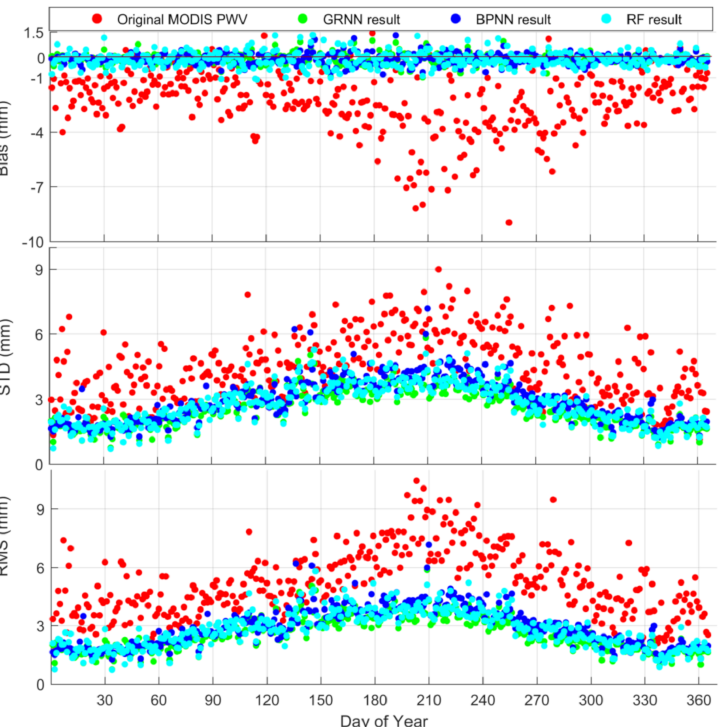
Figure 7. Daily accuracy for the original MODIS PWV and modified MODIS